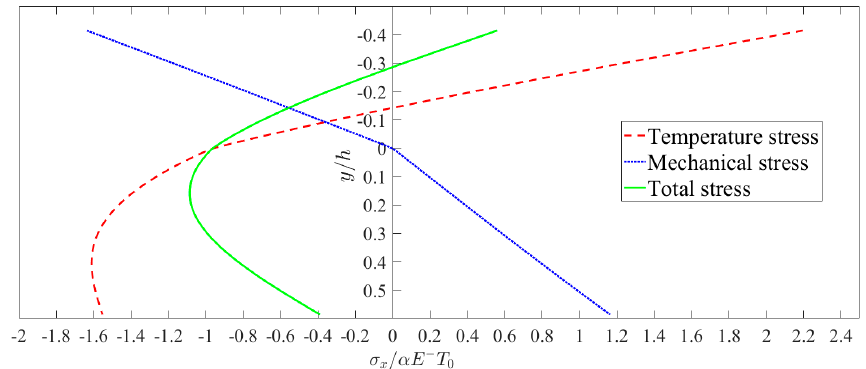
+ − = + − = + − = / 20 E T q α − = . and and 20 E T q α − = . and 20 E T q α − = . Figure 6. Stress composition when E + = 0.5 E − and α E − T = 0 0 / q